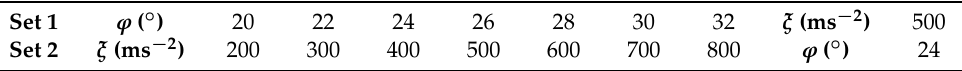
Table 4. Rheological parameter values assumed in the SPH sensitivity